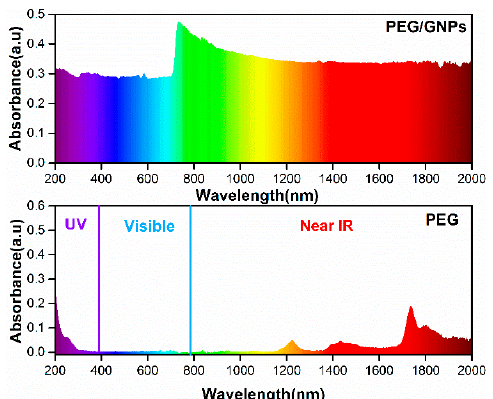
Figure 11. The Ultraviolet ‐ visible ‐ Near Infrared diffuse reflection spectra of pure PEG and PEG/GNPs ‐ 2%